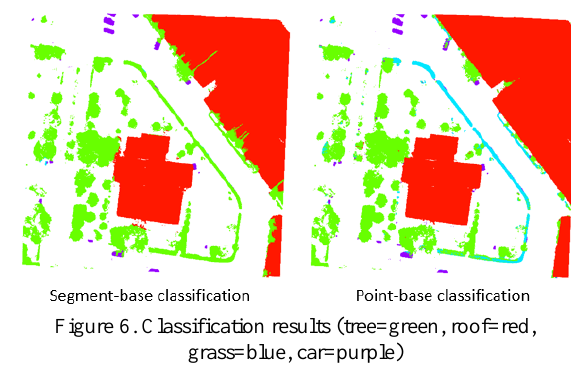
Figure 6. Classification results (tree=green, roof=red, grass=blue,